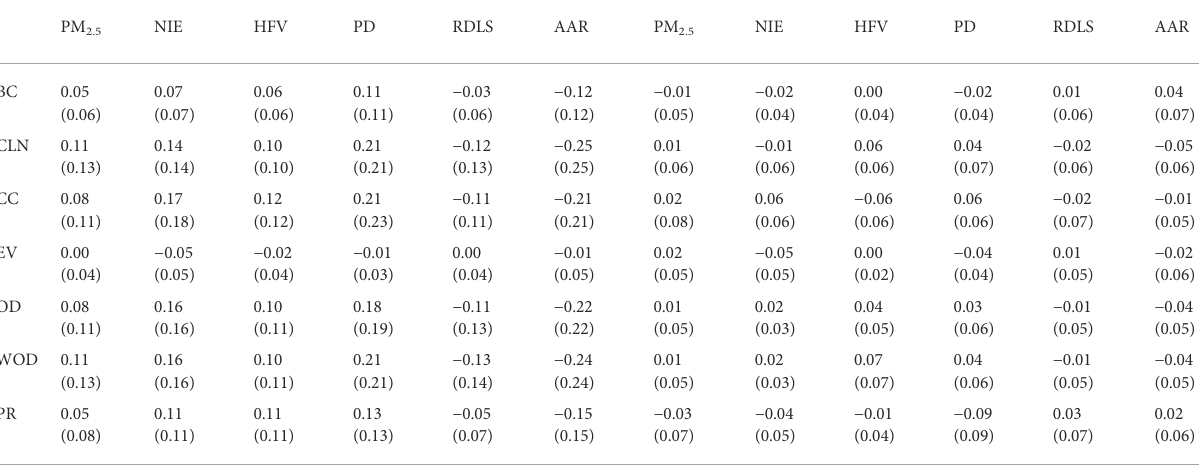
Panel C: Medium timescale Panel D: Long